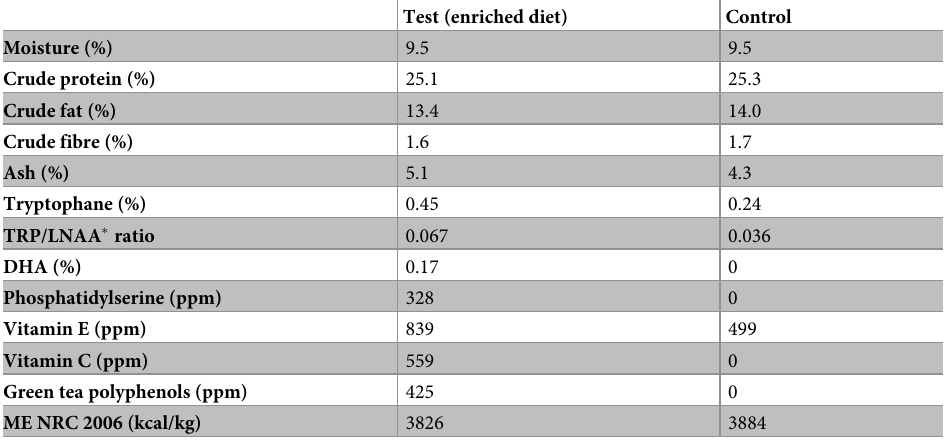
Table 1. Composition of test and control